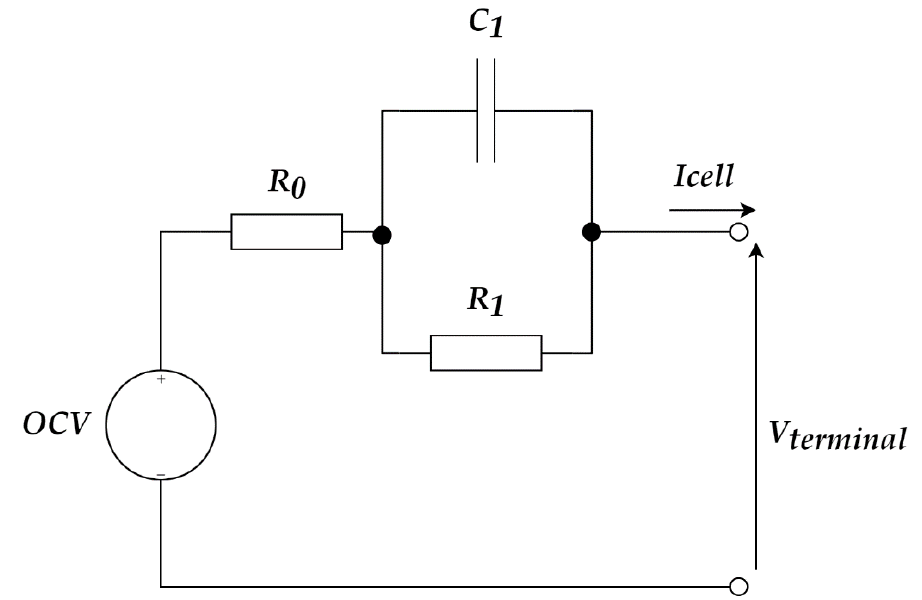
Figure 7. The equivalent circuit model with a single RC branch used for this study.